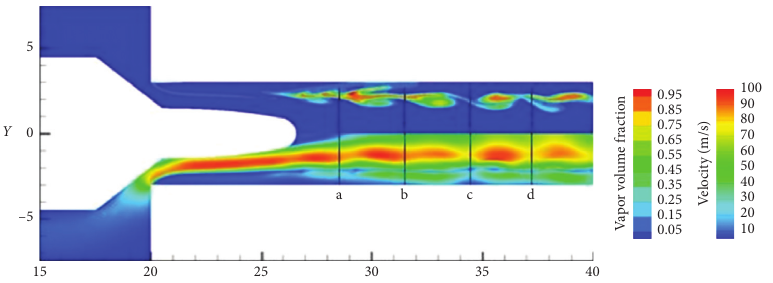
Figure 6: The distribution of a gas volume fraction (upper part) and velocity (down part) at the cavitation collapse process.